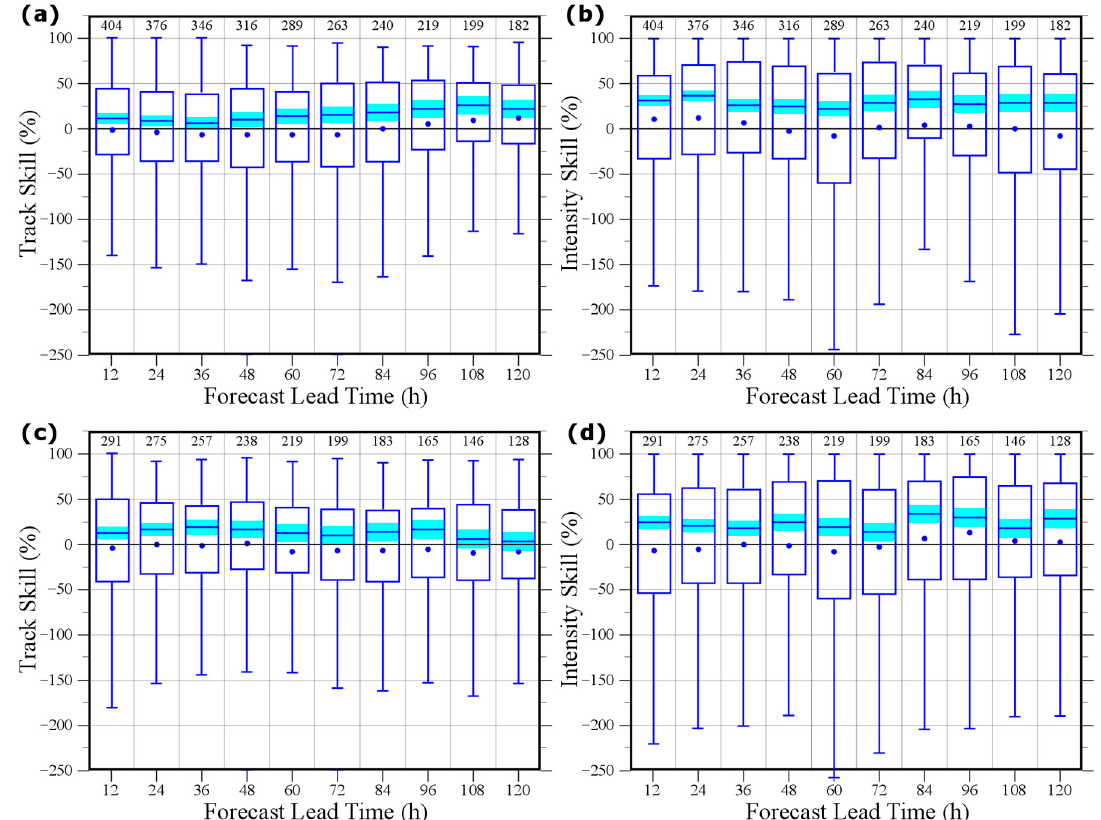
Figure 2. Box-and-whisker plots showing the distribution of HWRF-B forecast skill scores versus HWRF (Equation (1)) for 2017–2019 priority tropical cyclones (TCs) and 12–120 h forecast lead times in the ( a , b ) North Atlantic and ( c , d ) eastern North Pacific. Track forecast skill is shown in ( a , c ), and intensity forecast skill is shown in ( b , d ). The median is designated by a horizontal line within the box, and the sample mean is provided by a circle. The top (bottom) of the box represents the 75th (25th) percentile. The top whisker represents the smaller value of the maximum and the 75th percentile plus 150% of the interquartile range (IQR). The bottom whisker represents the greater value of the minimum and the 25th percentile minus 150% of the IQR. Light blue shading represents the 95% confidence interval centered on the median. The number of cases is printed at the top of each column.